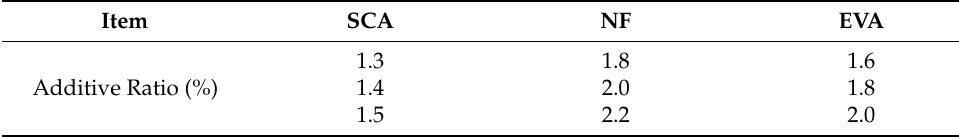
Table 10. The set range of compound